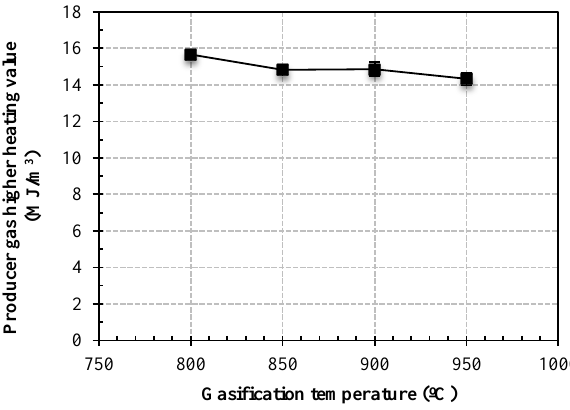
Figure 5. Effect of gasification temperature on producer gas higher heating value.